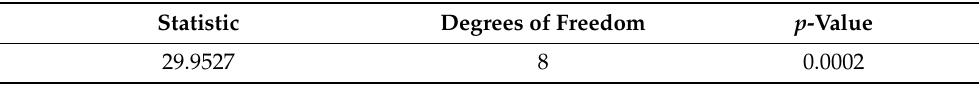
Table 3. Hausman test